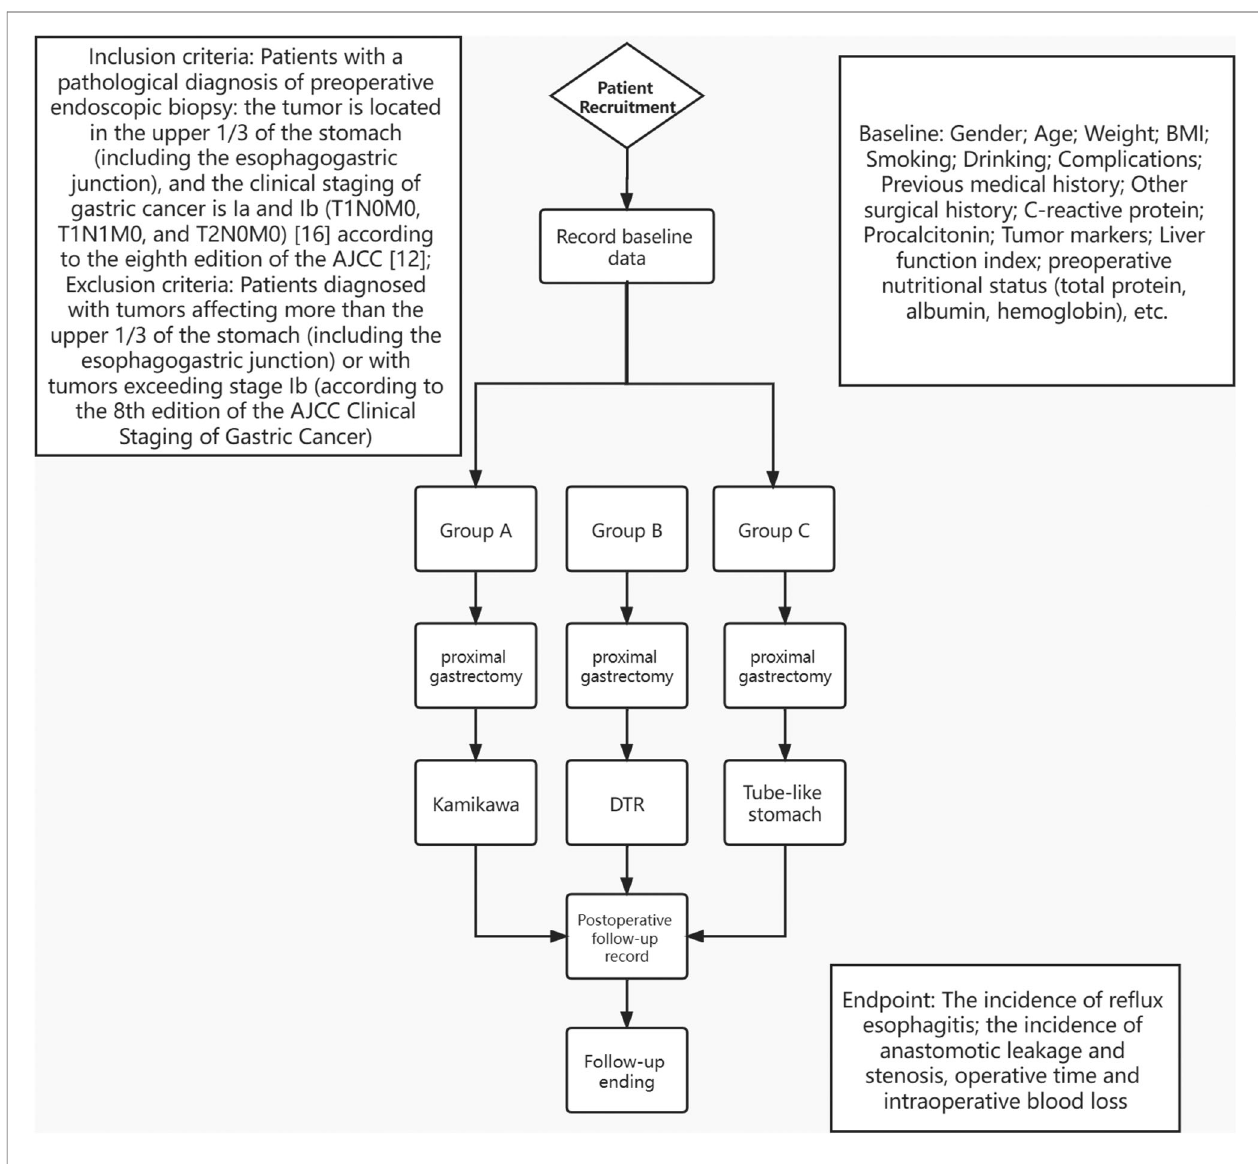
FIGURE 1 | This is the whole fl ow diagram of the